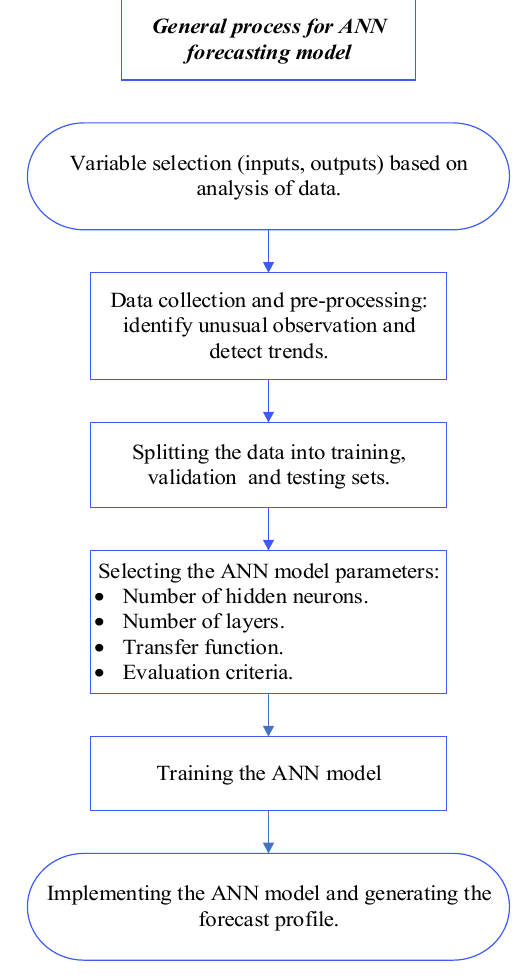
Figure 18. The methodology of the Artificial Neural Network (ANN) forecasting model.